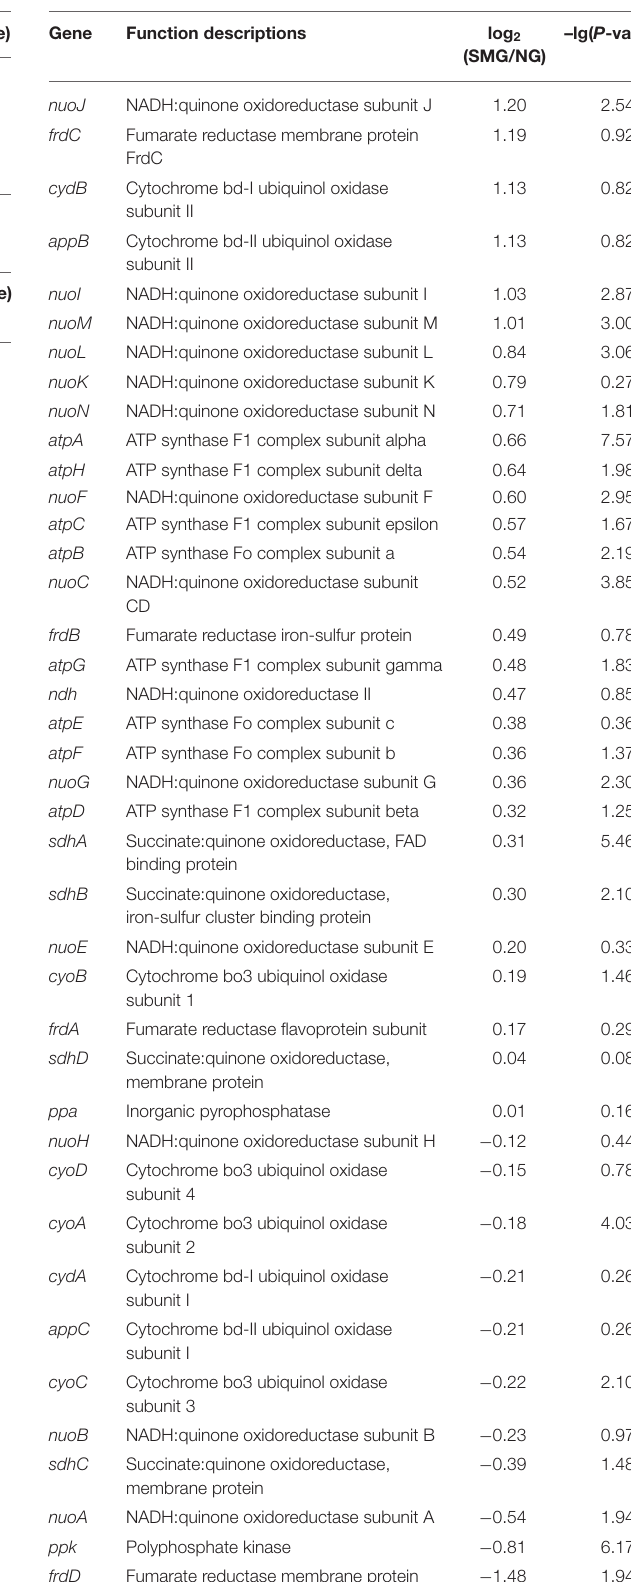
TABLE 5 | Transcription changes of oxidative phosphorylation